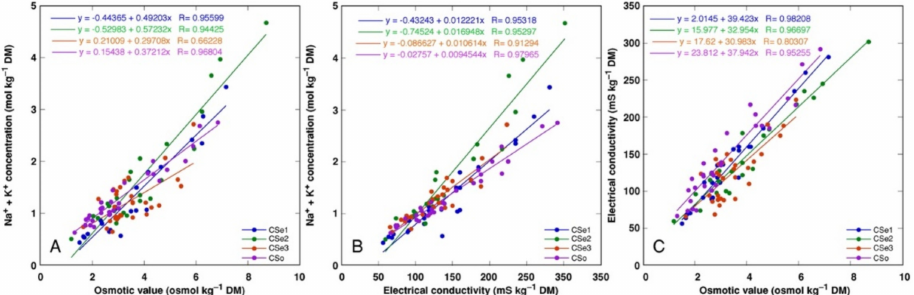
Figure 11. Correlation between Na + + K + concentration and osmotic value ( A ), Na + + K + concentra- tion and electrical conductivity ( B ), and electrical conductivity and osmotic values ( C ) in different parts of Calystegia sepium accessions CSe1, CSe2, CSe3 and Calystegia soldanella